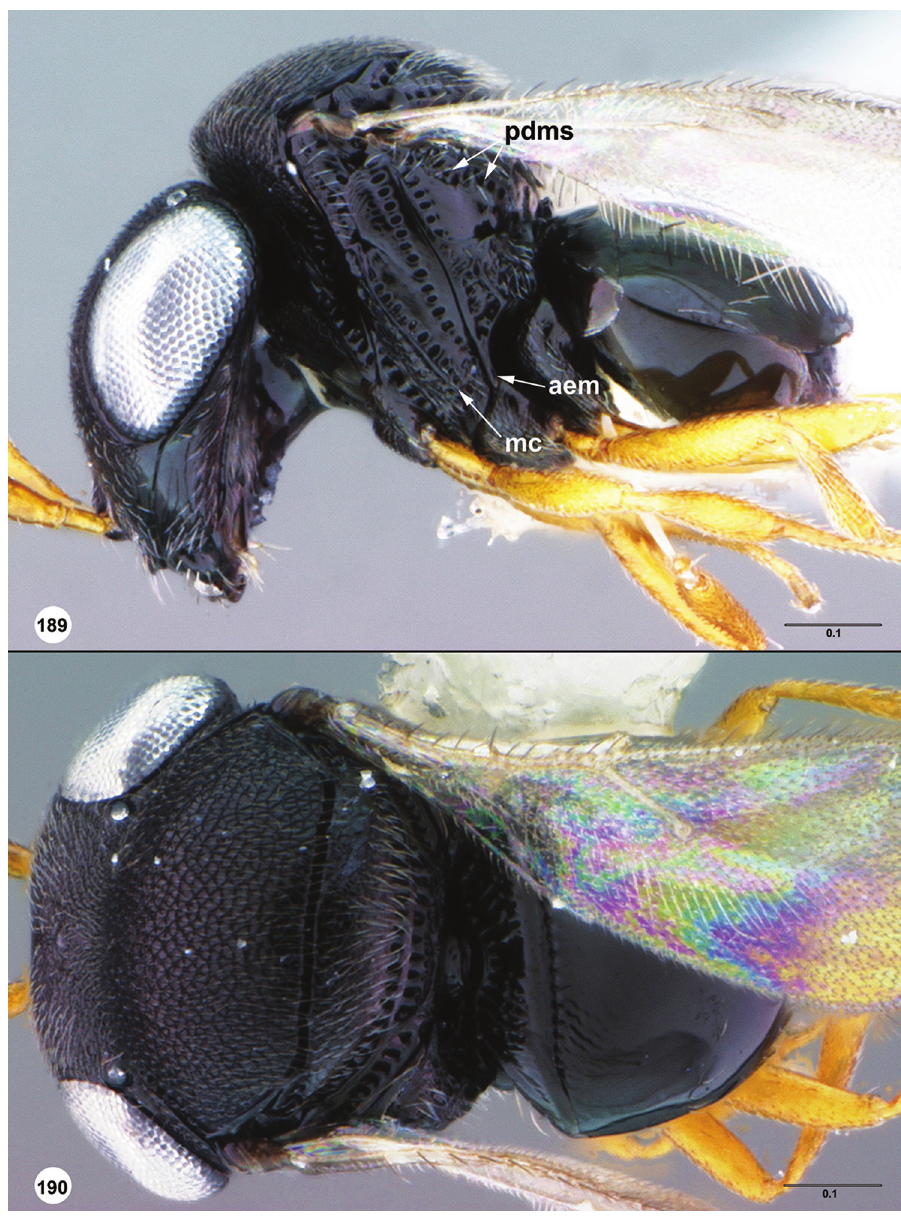
Figures 189–190. Trissolcus tersus female (EMBT ENT 0001839) 189 head, mesosoma, metasoma, lateral view 190 head, mesosoma, metasoma, dorsal view. Scale bars in millimeters. Mesosoma. Epomial carina: absent. Macrosculpture of lateral pronotum directly anterior to netrion: finely rugulose. Netrion sulcus: complete. Pronotal suprahumeral sulcus in posterior half of pronotum: undifferentiated from sculpture of dorsal